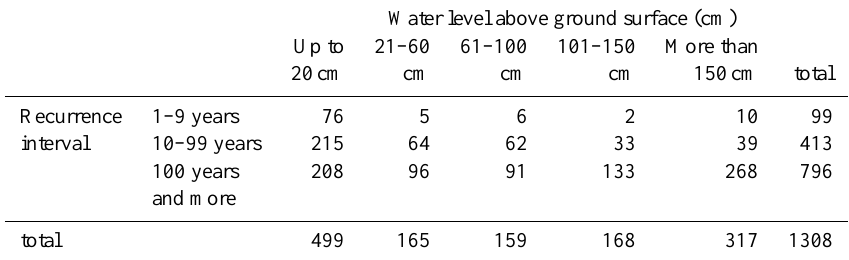
Table 1. Building loss cases per recurrence interval and water level class combination.